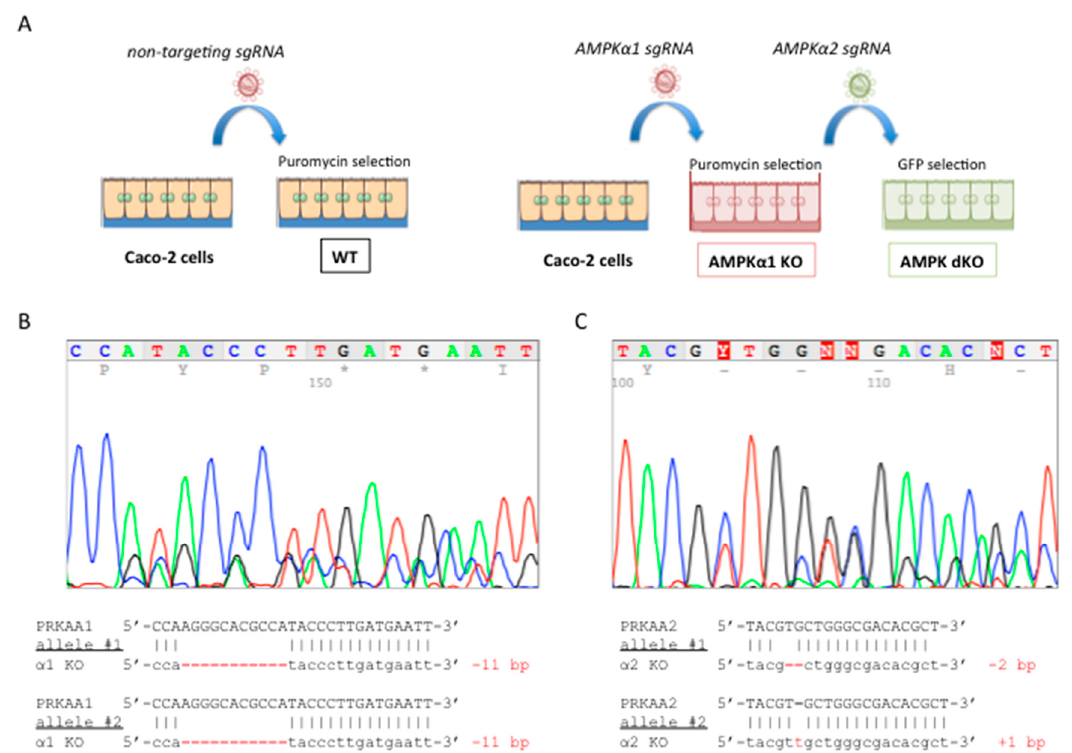
Figure 1. Generation and characterization of AMPK α 1 / α 2-deficient Caco-2 cells. ( A ) Experimental workflow for genome engineering of colon carcinoma Caco-2 cells. A sequential procedure was used to target first PRKAA1 gene encoding AMPK α 1 and then PRKAA2 gene encoding AMPK α 2. Cells expressing PRKAA1 -targeting sgRNAs were first selected on puromycin resistance and then cells on an AMPK α 1 knockout background expressing PRKAA2 -targeting sgRNAs were selected on green fluorescent protein (GFP) expression. Control cells were generated by using a non-targeting sgRNA and were selected on puromycin resistance. ( B ) Sequencing analysis of PRKAA1 CRISPR alleles shows that both alleles were modified by deletion of 11 bp, resulting in premature stop codons. ( C ) Sequencing analysis of PRKAA2 CRISPR alleles shows that one allele displayed a deletion of 2 bp and the second allele an insertion of 1 bp. All these alleles result in premature stop codons.